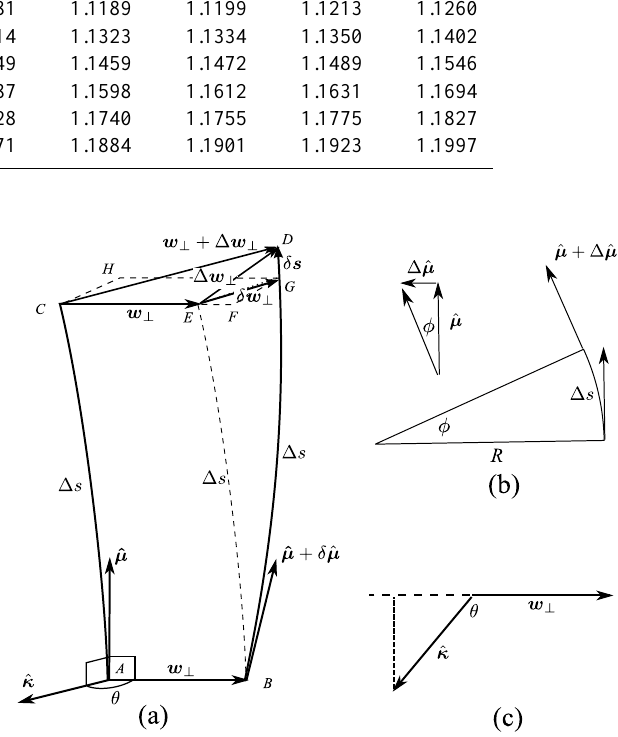
Figure 3. Definition of T ij . (a) Relative displacement of adjacent field lines; (b) Field line curvature; (c) Component of w ⊥ along curvature